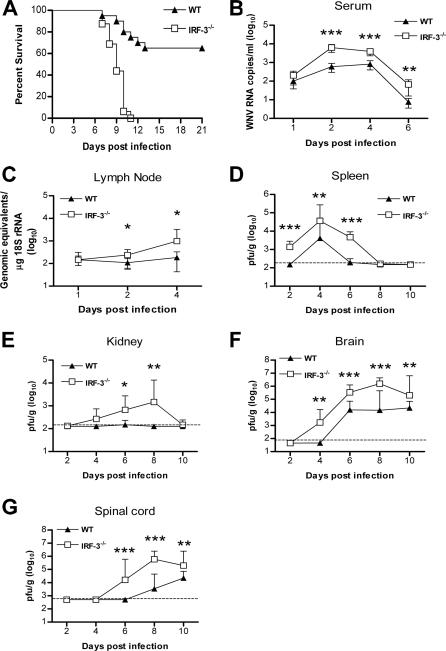
Survival and Virologic Analysis for Wild-Type and IRF-3−/− C57BL/6 Mice(A) Eight- to twelve-week-old mice were inoculated with 102 PFU of WNV by footpad injection and followed for mortality for 21 d. Survival differences were statistically significant (n = 20, IRF-3−/−; and n = 20, wild-type mice; p < 0.0001).(B–G) Viral burden in peripheral and CNS tissues after WNV infection. WNV RNA in (B) serum and (C) draining lymph node, and infectious virus in the (D) spleen, (E) kidney, (F) brain, and (G) spinal cord were determined from samples harvested on days 1, 2, 4, 6, 8, and 10 using qRT-PCR (B, C) or viral plaque assay (D–G). Data is shown as viral RNA equivalents or PFU per gram of tissue for ten to 12 mice per time point. For all viral load data, the solid line represents the median PFU per gram at the indicated time point, and the dotted line represents the limit of sensitivity of the assay. Error bars indicate the standard deviations (SD). Asterisks indicate values that are statistically significant (*, p < 0.05; **, p < 0.005; ***, p < 0.0001) compared to wild-type mice.